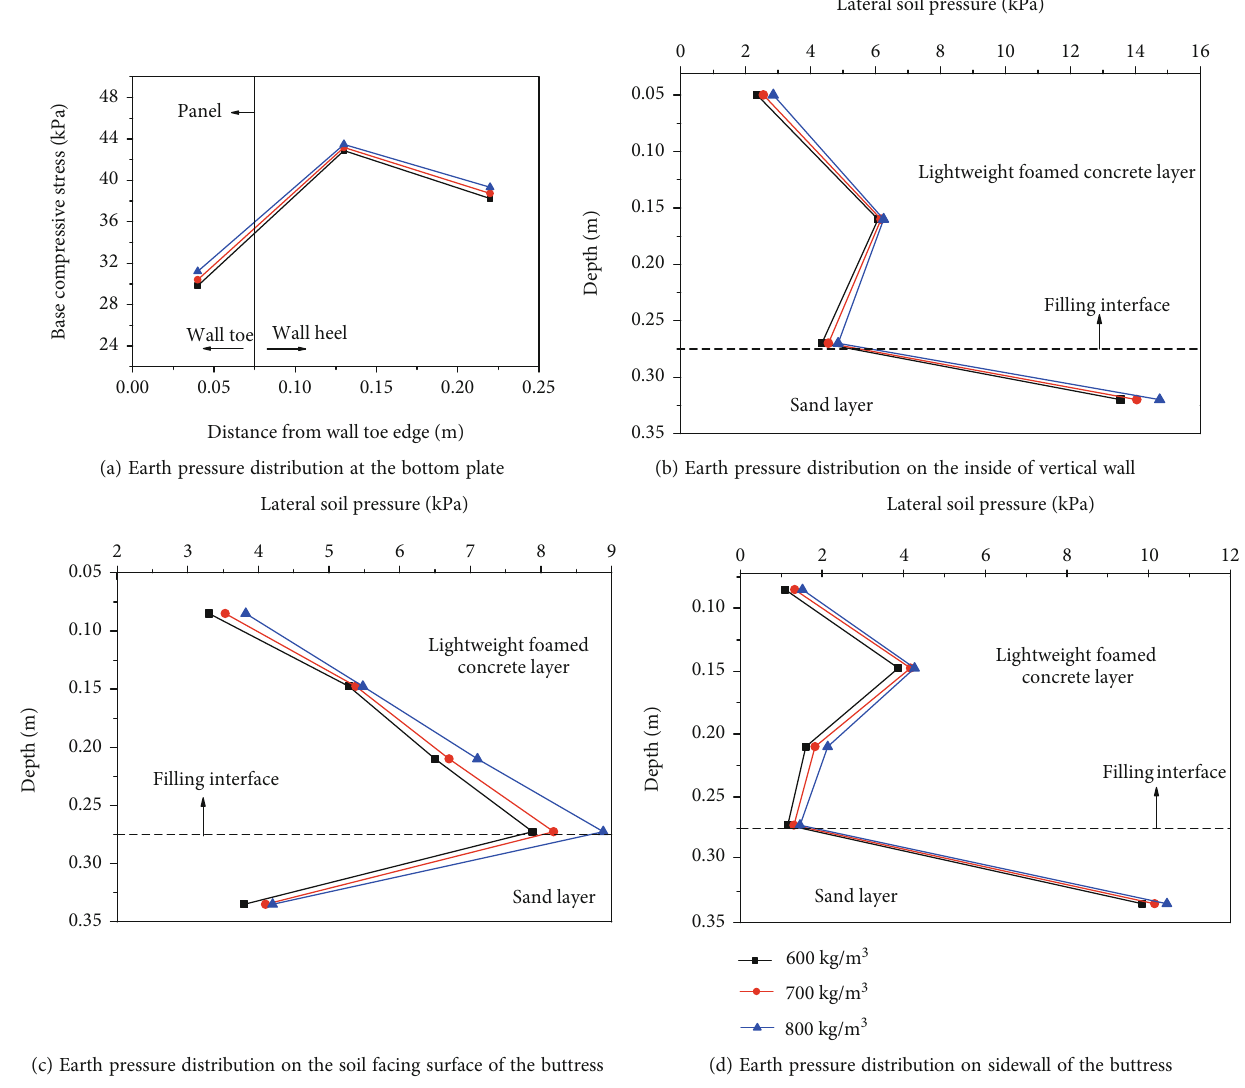
Figure 10: Earth pressure distributions of retaining wall under di ff erent densities of lightweight foamed